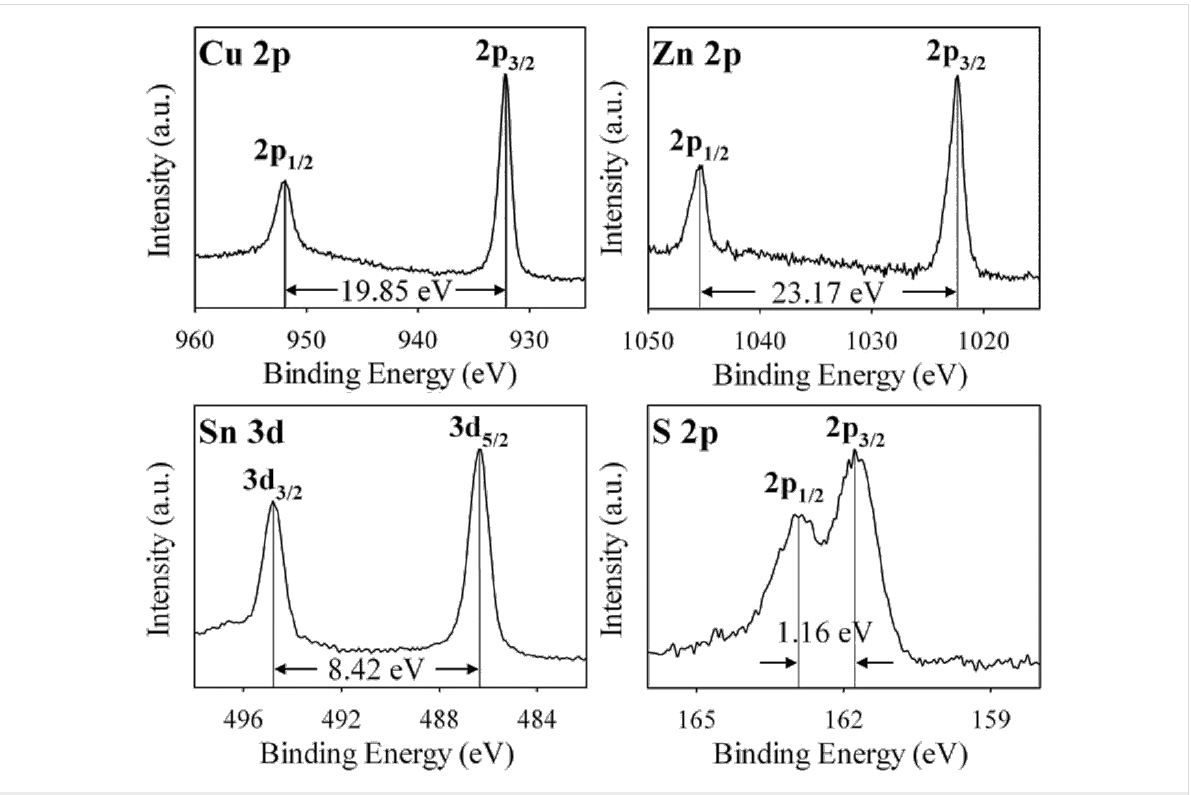
Figure 2: XPS spectra of CZTS nanocrystals synthesized at 240 °C for 24 h.